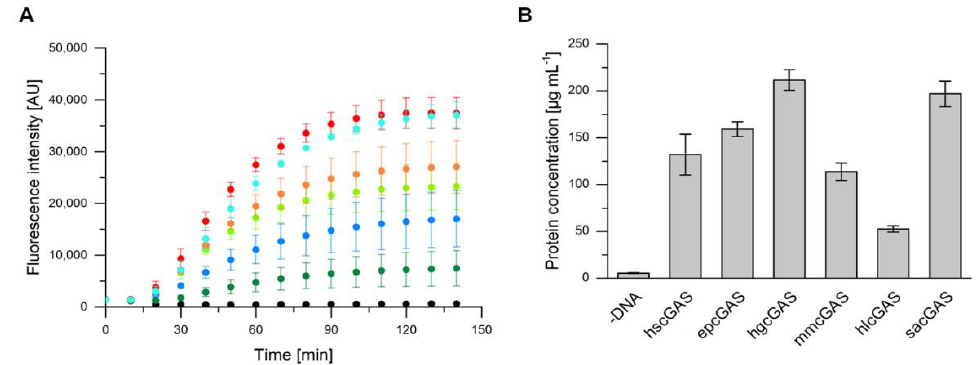
Figure 3. ( A ) Cell-free protein synthesis of superfolder green fluorescent protein (sfGFP)-tagged cyclic GMP-AMP synthases (cGAS) originating from di ff erent metazoans performed in a micro plate reader at 30 ◦ C. Black dots represent the negative control, which consisted of protein synthesis mix without a DNA template, light green human (hs), orange Przewalski’s horse (ep), red naked mole-rat (hg), dark blue house mouse (mm), dark green bald eagle (hl), and light blue Sinocyclocheilus anshuiensis (sa) cGAS. Error bars relate to biological triplicates. ( B ) Protein concentrations obtained withcell-free protein synthesis (CFPS). Concentrations were calculated based on fluorescence intensity and a standard curve with purified sfGFP. Error bars relate to technical triplicates.